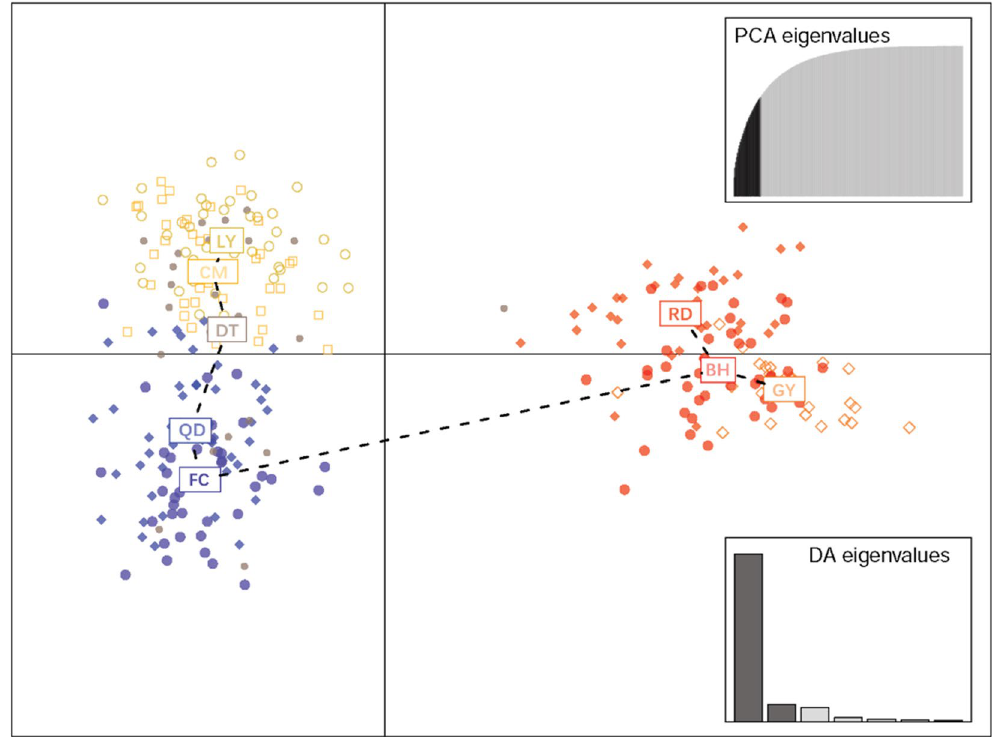
Figure 3. DAPC plot diagram of L. maculatus populations. LY Lieyu, CM Chongming, DT Dongtou, QD Qingdao, FC Fangcheng, GY Ganyu, RD Rudong, BH Binhai. Colored dots with different shapes represent individuals from different geographical populations, PCA and DA scatterplots on the right side of the graph indicate the principal components and numbers of discriminant functions for the